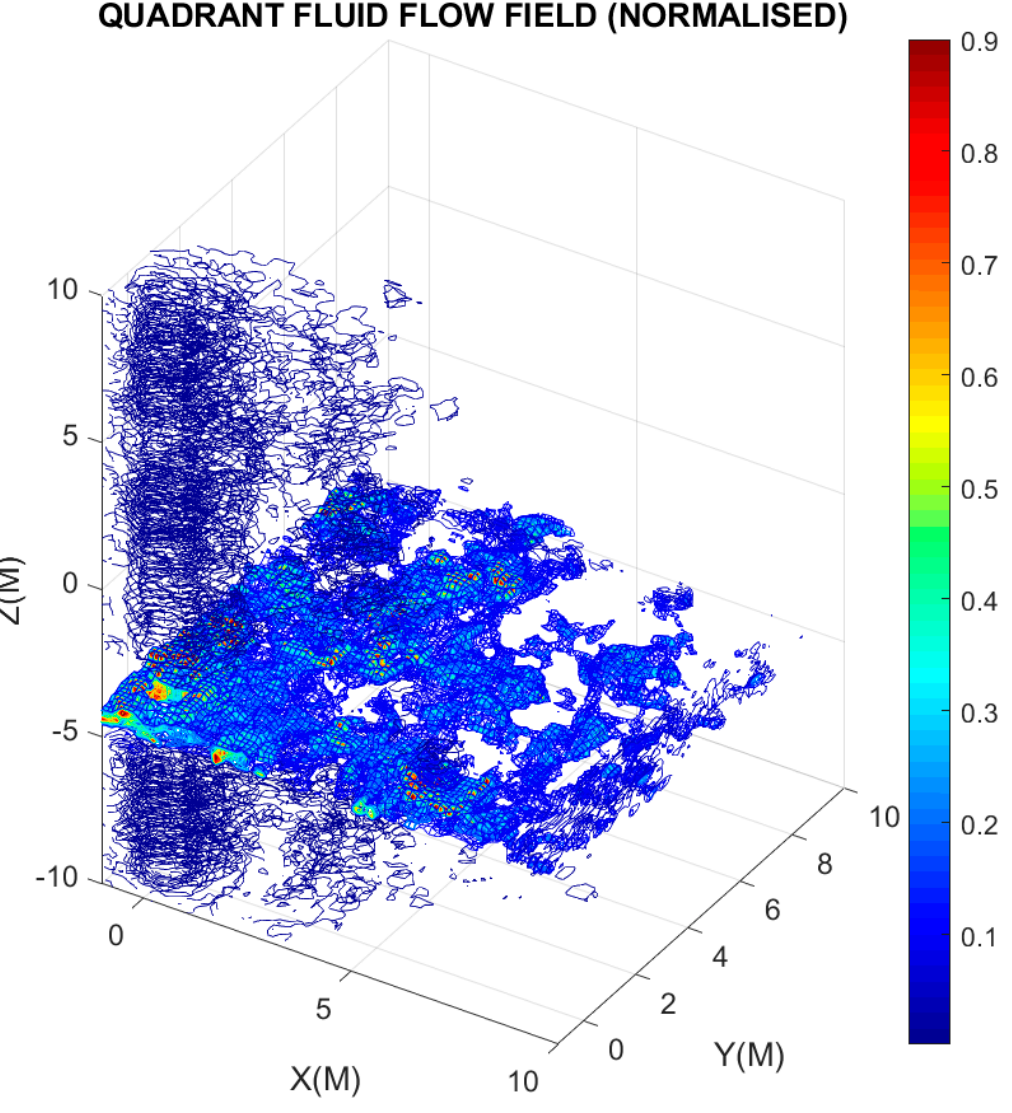
Figure 9. Quarter section of normalised advective heat flow distribution over wellbore-centric computational volume for thin fracture-connectivity plane illustrated in Figure 7. The temperature field associated with the displayed advective flow distribution is shown in Figure 8. Wellbore axis is located at (x,y) = (0,0). Model dimensions in meters.